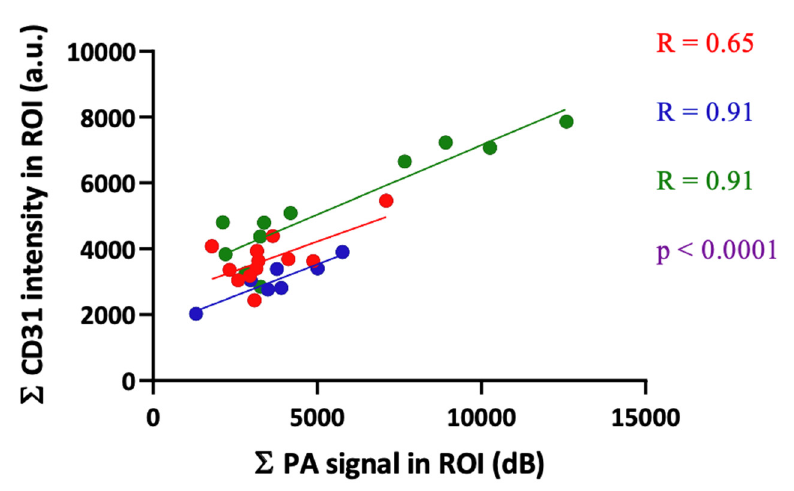
Figure 5. Correlation between background subtracted signal intensity from PA images and CD31 immunofluorescence (IF) image. Each color represents data from different mice. A total of 30 ROIs from three mice were used in our analysis. The R-value for correlation based on Pearson’s coefficient was calculated between the CD31 intensity from the IF image and PA signals from blood vessels.